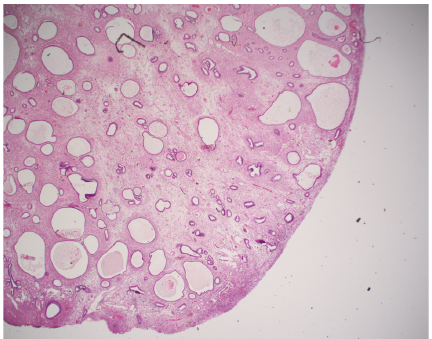
Figure 6: Microscopic section of polyp from case #2. H&E stain, low-power photomicrographs showing intact polypoid tissue cystic dilated glands without evidence of hyperplasia, fibrotic stroma, and dilated thick-walled